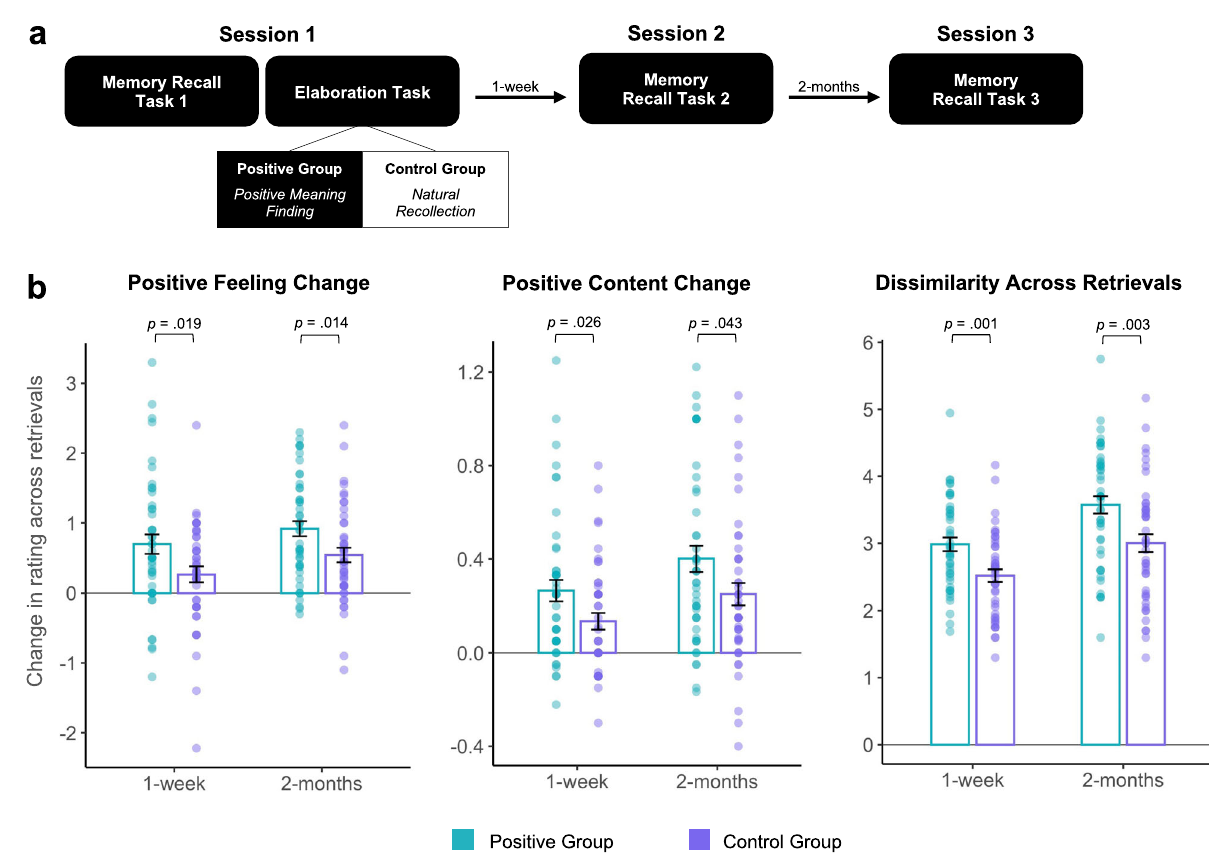
Fig. 3 Memory change over 2-months. Experiment 2: a Timeline; b The Positive group ( n = 46) exhibited greater positive emotion, positive content, and more dissimilar content both 1-week and 2-months later relative to the Control group (natural recollection; n = 45). Analyses were two-tailed t-tests. Overlaid dots represent individual participants. Bars show mean values per group and condition; error bars = ±SEM. Source data are provided as a Source Data fi